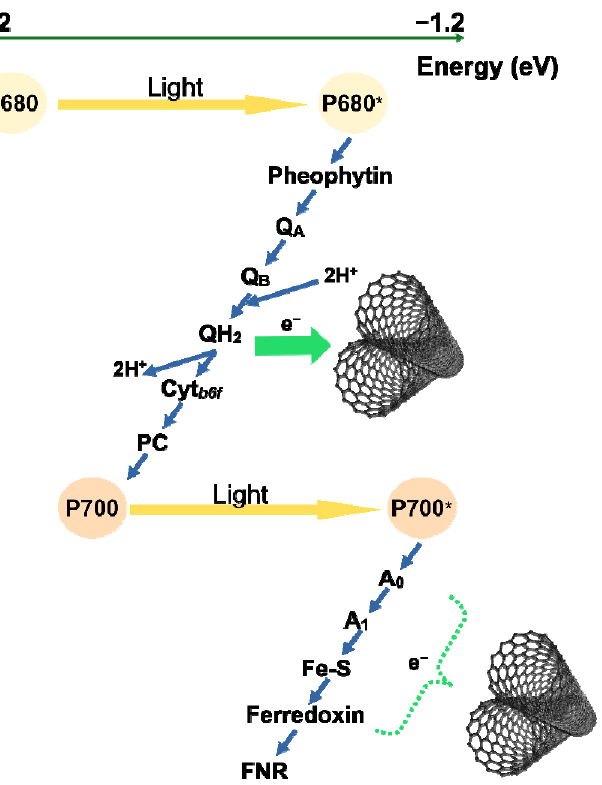
Figure 6. Proposed mechanism of interaction between the photosynthetic electron transport chain of higher plants and P85 polymer-modified SWCNT. SWCNT are capable to divert electrons from the photosynthetic electron transport chain at the level of plastoquinone pool and/or photosystem I end acceptors in vivo.